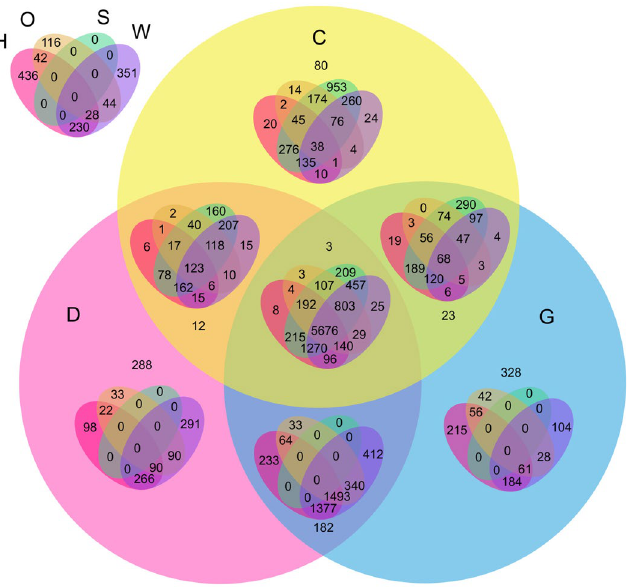
Figure 4. 7-set Venn diagram of gene ids present in A subunit across all stress conditions. H: Heat, O: Osmotic, S: Salt, W: Wounding, D: Drought, C: Cold, G: Genotoxic. The 7-set venn diagram illustrates the count of genes in all 127 possible combinations.